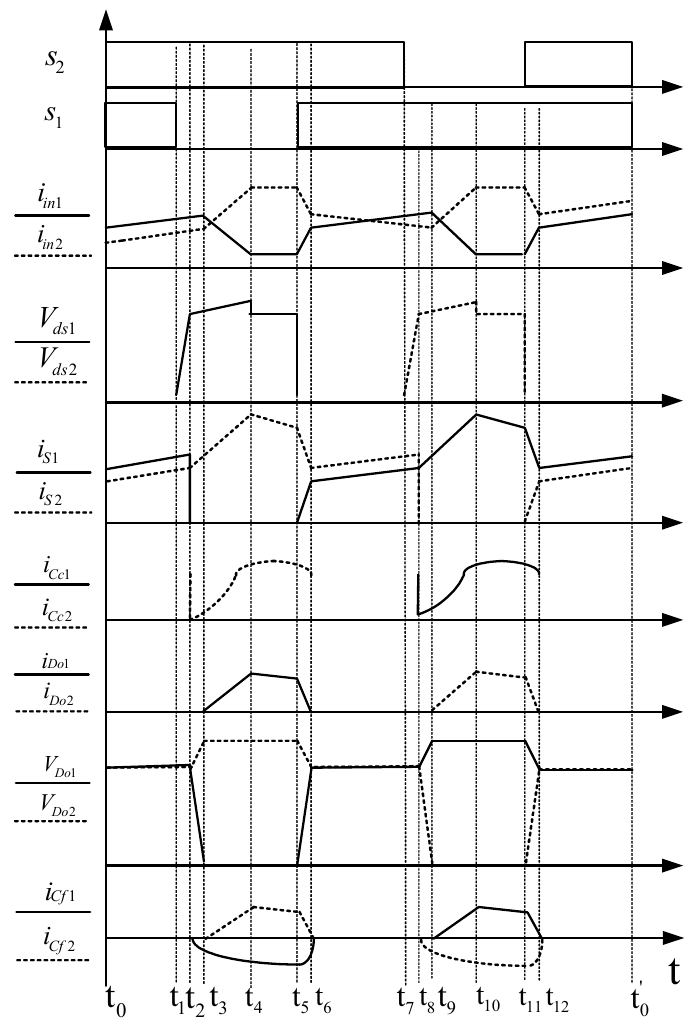
Figure 3. Key waveforms of the interleaved high step-up current sharing converter.